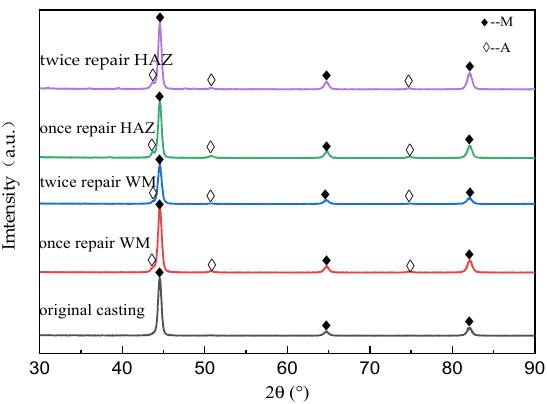
Figure 2. X-ray diffraction patterns of casting and repair welding joint.